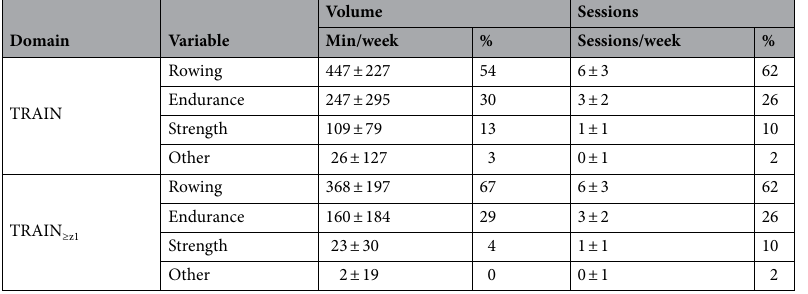
Table 2. Training volume and sessions spent in different training modes calculated for all logged training (TRAIN) data and exclusively for intensities equal or higher than 60% of maximum heart rate (TRAIN ≥z1 ). Data are provided as arithmetic mean ± standard deviation or percentage within domain, respectively.